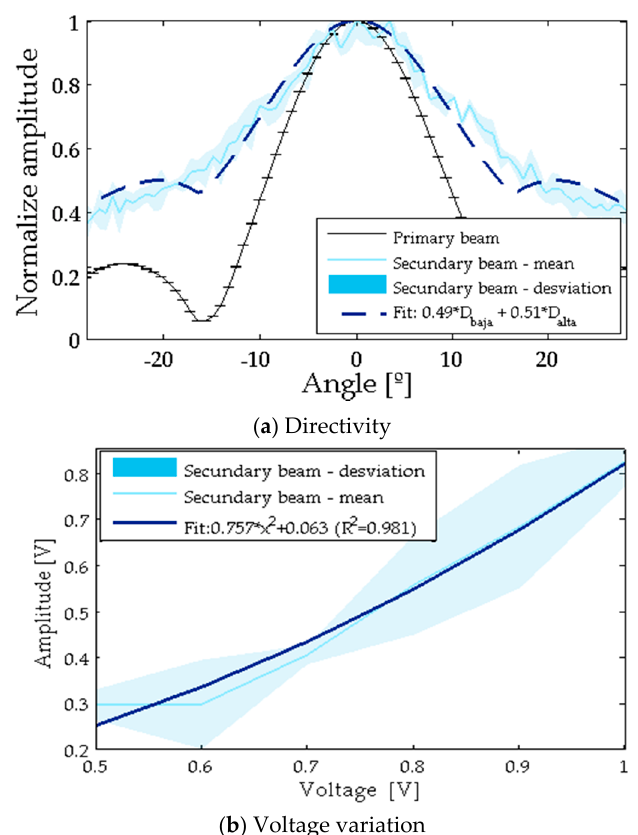
Figure 5. Magnitudes to characterize. ( a ) Directivity; ( b ) Tension